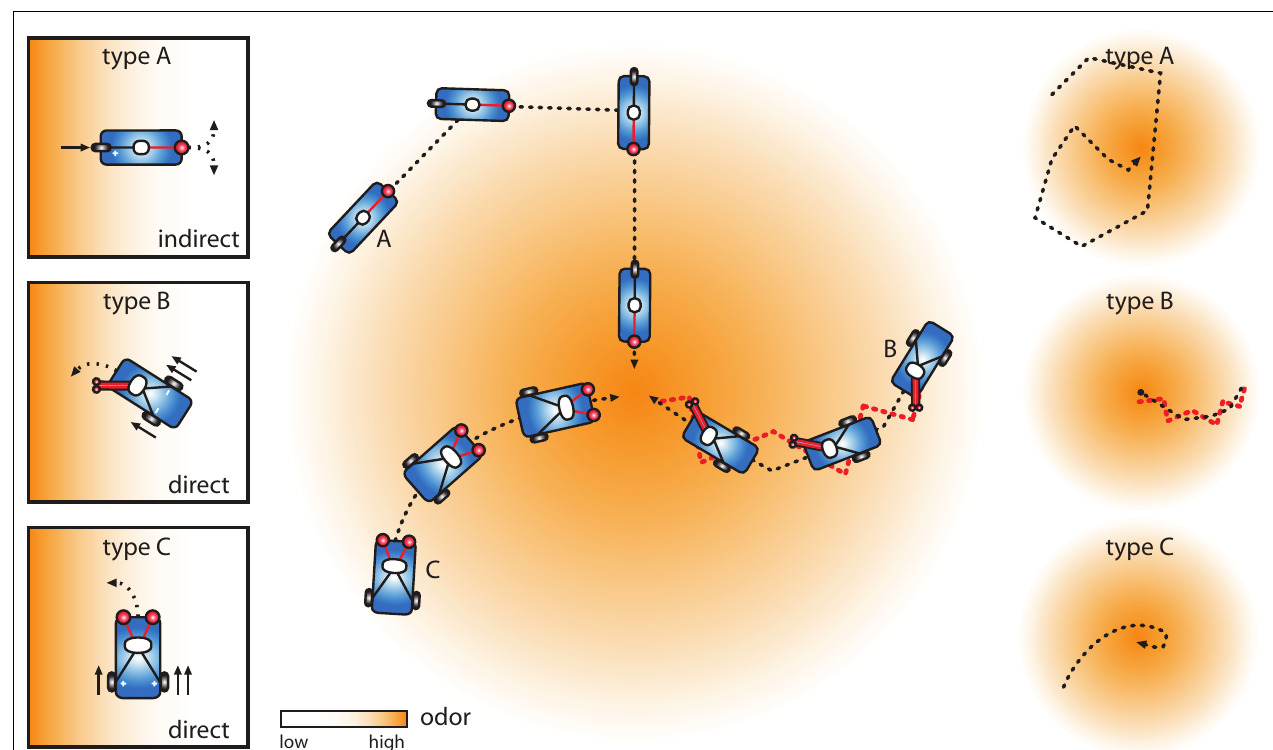
aligned with the vector fi eld of the stimulus gradient ( taxis ). The type C vehicle has the capacity to simultaneously measure concentrations at different points in space via purely spatial comparisons ( osmotropotaxis ). The underlying orientation rule is: If the difference in concentration across the two sensors is zero, increase the activation both motors at a level proportional to the sensory input. Conversely, if a concentration difference is measured across the two sensors, activate more strongly the motor opposite the side of highest odor concentration. This rule results in a trajectory aligned with the vector fi eld of the stimulus gradient. Behaviors following source acquisition are illustrated in the panels on the